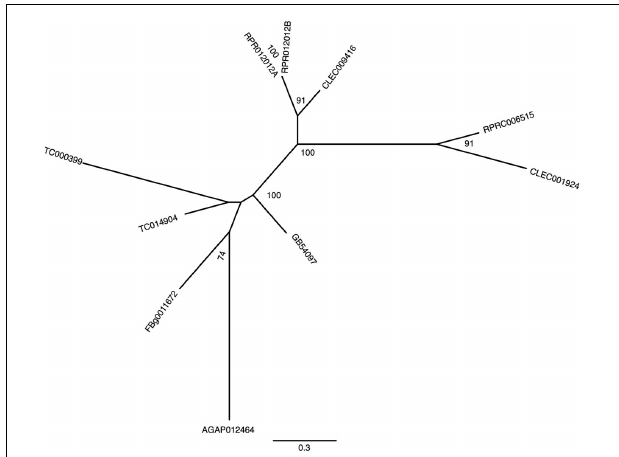
FIGURE 5 | Phylogenetic analysis of malvolio orthologs. Maximum-likelihood tree of Malvolio orthologs. Numbers on the branches are bootstrap support values from 500 replicates. Only numbers 50% or higher are shown. The sequence codes used were R. prolixus (RPRC), D. melanogaster (FBg), T. castaneum (TC), C. lectularius (CLEC), A. mellifera (GB) and A. gambiae